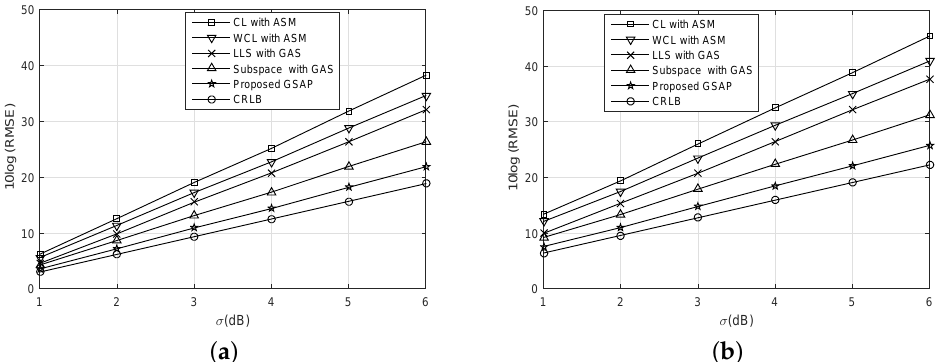
Figure 4. Root mean square error (RMSE) performance vs. σ dB . ( a ) AMs uniformly distributed over the whole area; ( b ) AMs distributed uniformly in the lower left corner.